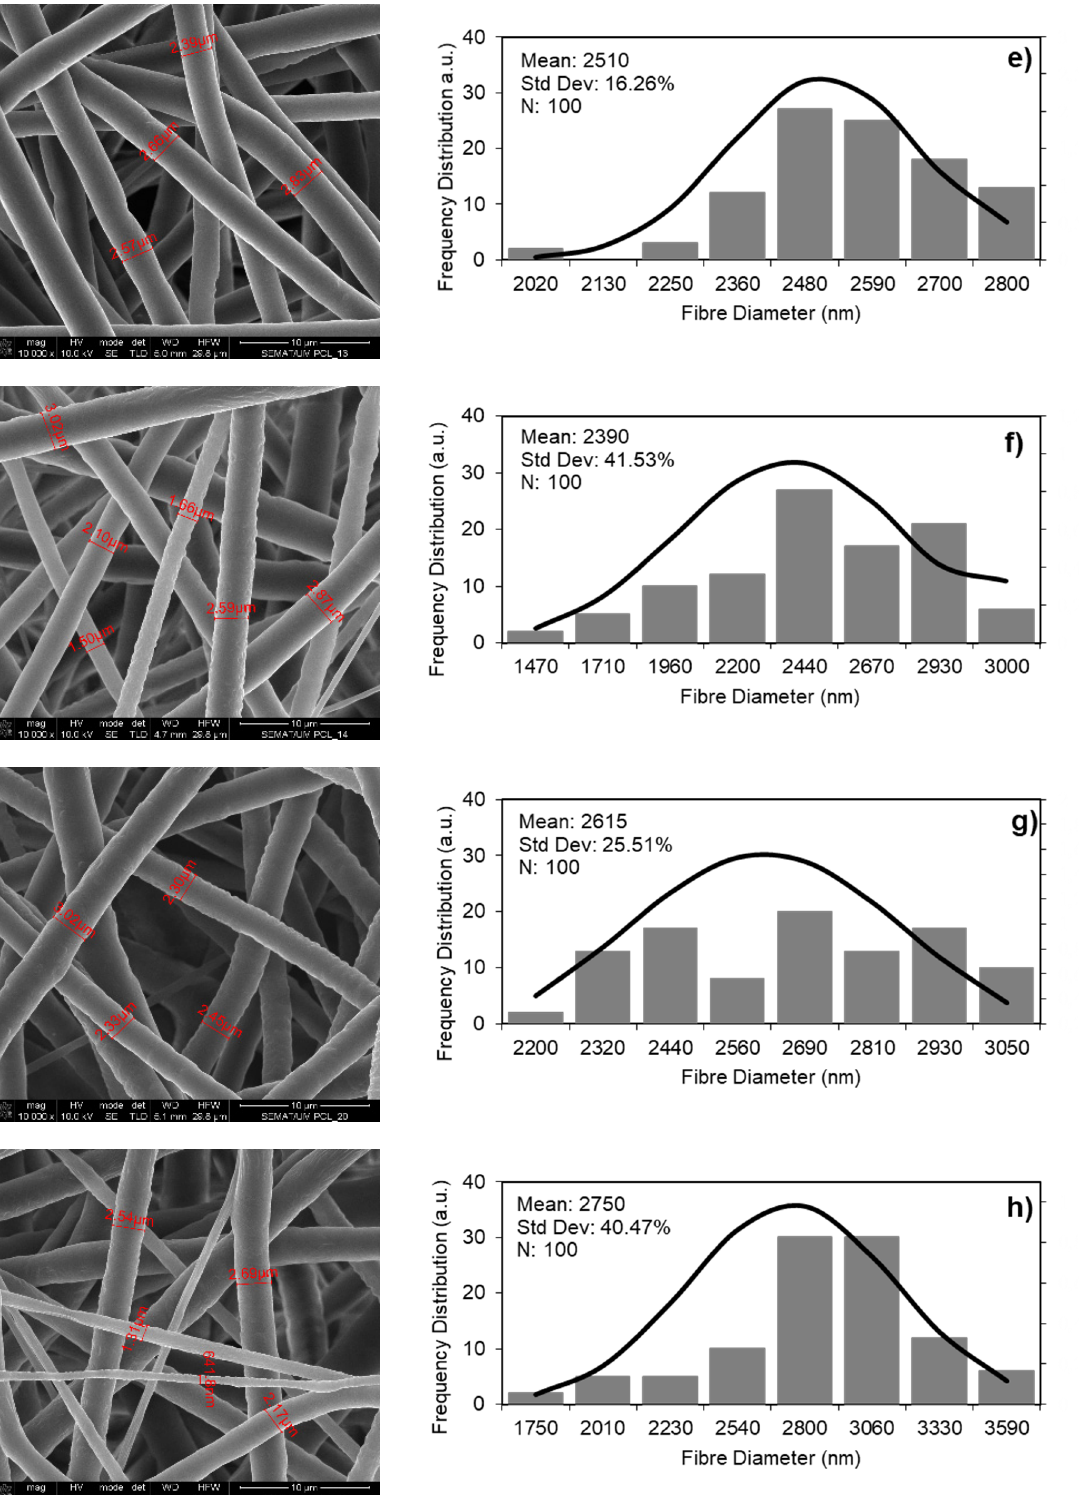
Figure 4. FESEM images of the electrospun PCL fibers and their diameter distribution histograms produced with different process conditions (applied voltage, flow rate, and needle-collector distance: ( a ) 25 kV, 240 mm, 1 mL/h; ( b ) 25 kV, 240 mm, 2 mL/h; ( c ) 28 kV, 240 mm, 1 mL/h; ( d ) 28 kV, 240 mm, 2 mL/h; ( e ) 25 kV, 260 mm, 1 mL/h; ( f ) 25 kV, 260 mm, 2 mL/h; ( g ) 28 kV, 260 mm, 1 mL/h; ( h ) 28 kV, 260 mm, 2 mL/h, to a PCL concentration of 15% ( w/v ) in CHF/DMF (4:1).